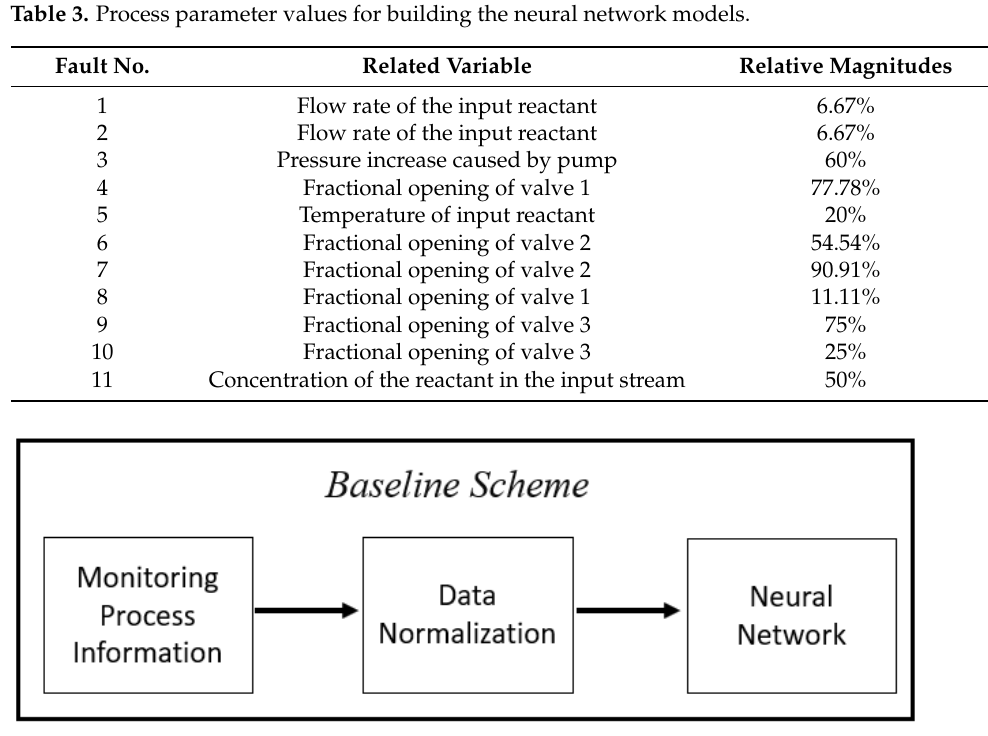
Figure 6. Framework of conventional neural network based fault diagnosis scheme. Table 3. Process parameter values for building the neural network models. Fault No.